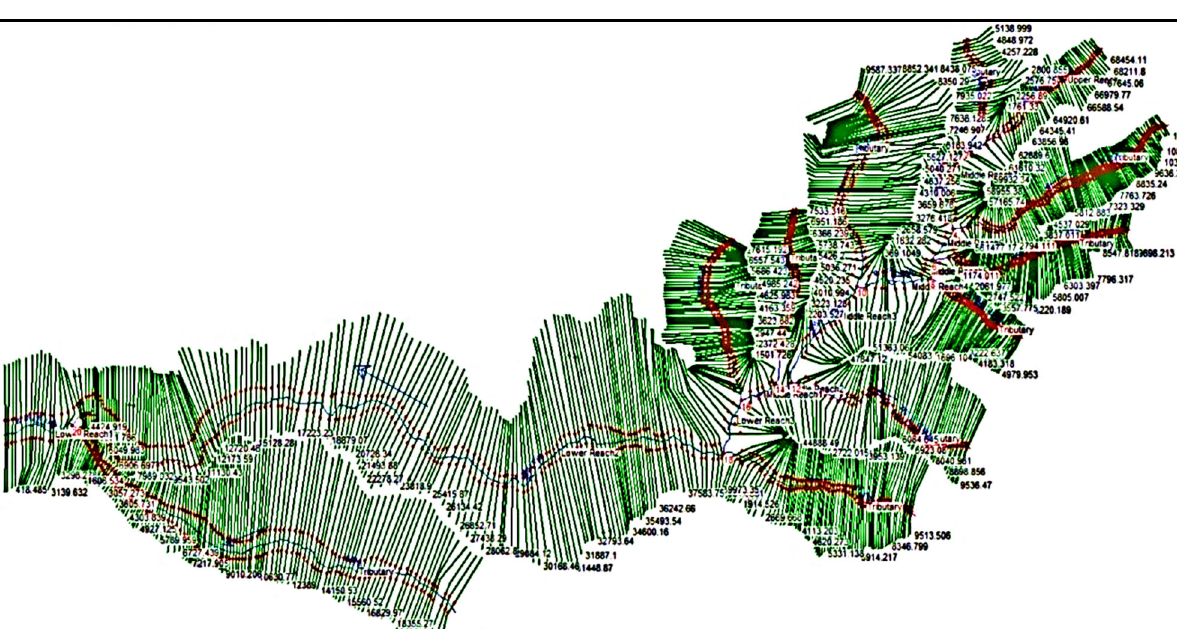
Figure 4. TIN of the Manafwa River Basin.